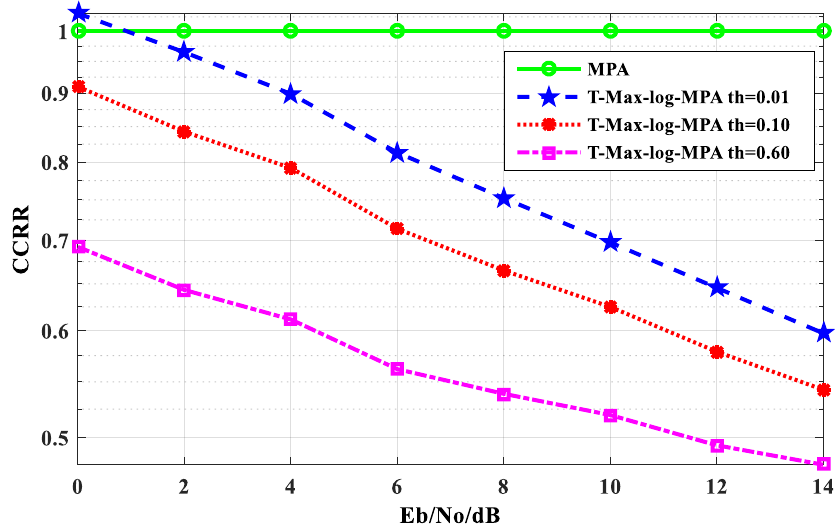
Figure 7. Comparison of the CCRR between the MPA algorithm and the T-Max-log-MPA algorithm.